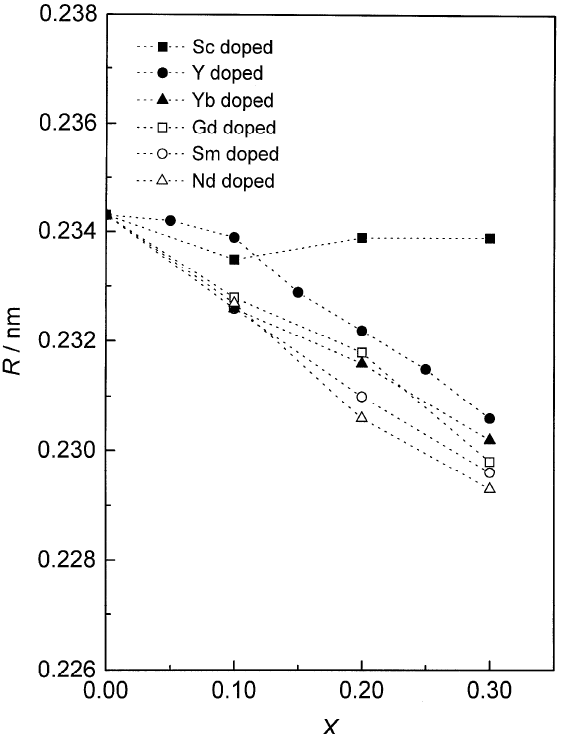
Figure 3. Trends of the Ce–O interatomic distances in ceria doped with Sc, Y, Yb, Gd, Sm, and Nd as a function of dopant concentration x [31].